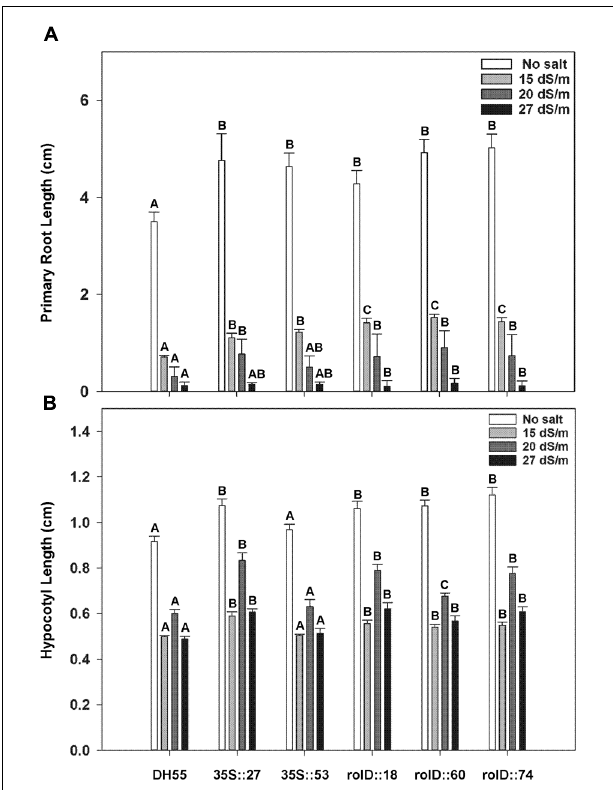
FIGURE 6 | The effect of acdS expression on hypocotyl and primary root length during germination of camelina seeds in the absence, or presence of, salt (15, 20, and 27 dSm − 1 ). Lines tested include wild-type C. sativa DH55 or independent, single insert, homozygous transgenic lines expressing the acdS gene under the control of the root-specific rolD promoter or the constitutive CaMV 35S promoter. (A) Shows primary root length and (B) hypocotyl length on day 6. Error bars indicate standard error [60 seeds divided in three plates (20 seeds/plate)]. A two-way ANOVA and Tukey post-test were used to detect significant differences between groups. Capital letters above bars indicate values that are significantly different ( p < 0.05) between lines for each salt concentration.